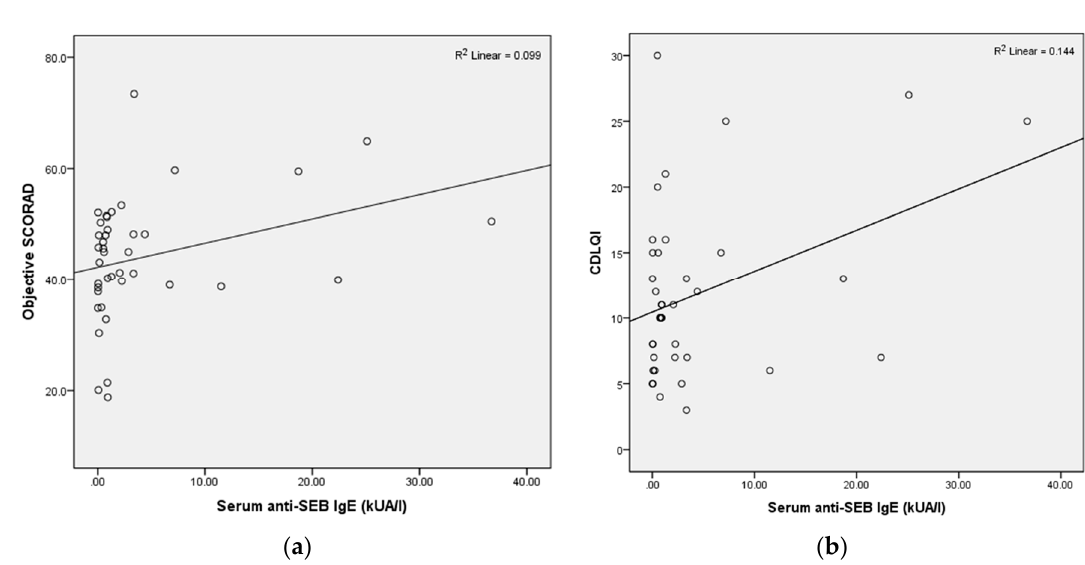
Figure 1. Scatterplots of serum anti-SEB IgE with ( a ) objective SCORAD and ( b ) CDLQI.